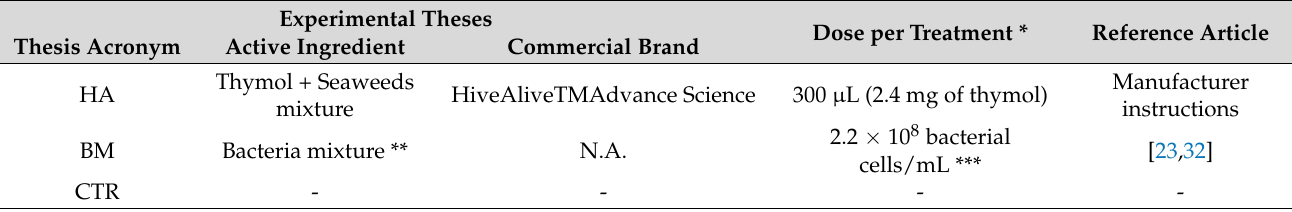
Table 1. Feed additives used in this work, their dosages applied in each treatment per hive in the presented trials, and recommended doses for full size colonies. * Dose recalculated according to the colony size of nucs, expressed as µ L of active ingredient dissolved in 30 mL of sugar syrup. ** Total recommended dose for 3 administrations with weekly cadence; *** Prepared according to [23,32], 4 different administered with weekly